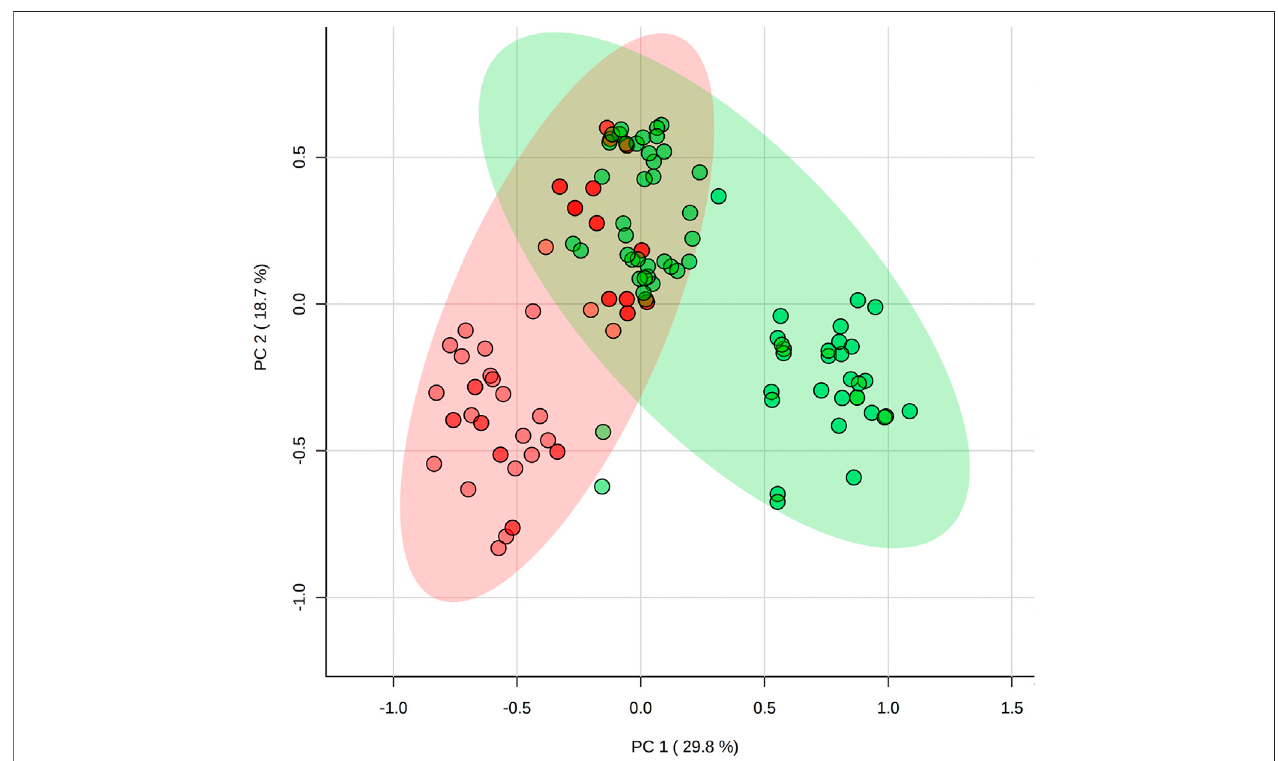
FIGURE 3 | Comparison of post-game metabolomes (metabolic pro fi le) between backcourt and frontcourt players during elite male basketball games using principal component analysis. Red: backcourt, green: frontcourt.